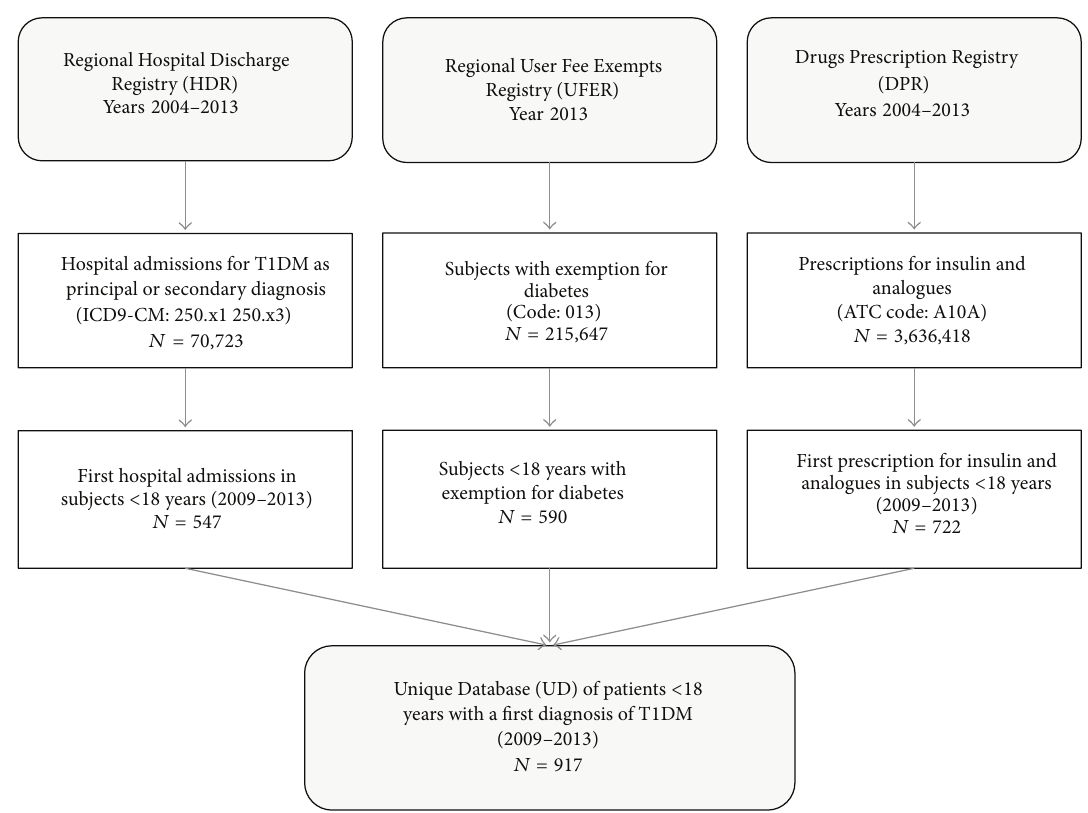
Figure 1: Flowchart of the creation of the total number of patients < 18 years with T1DM (the Unique Database). Apulia, Italy, 2009–2013.